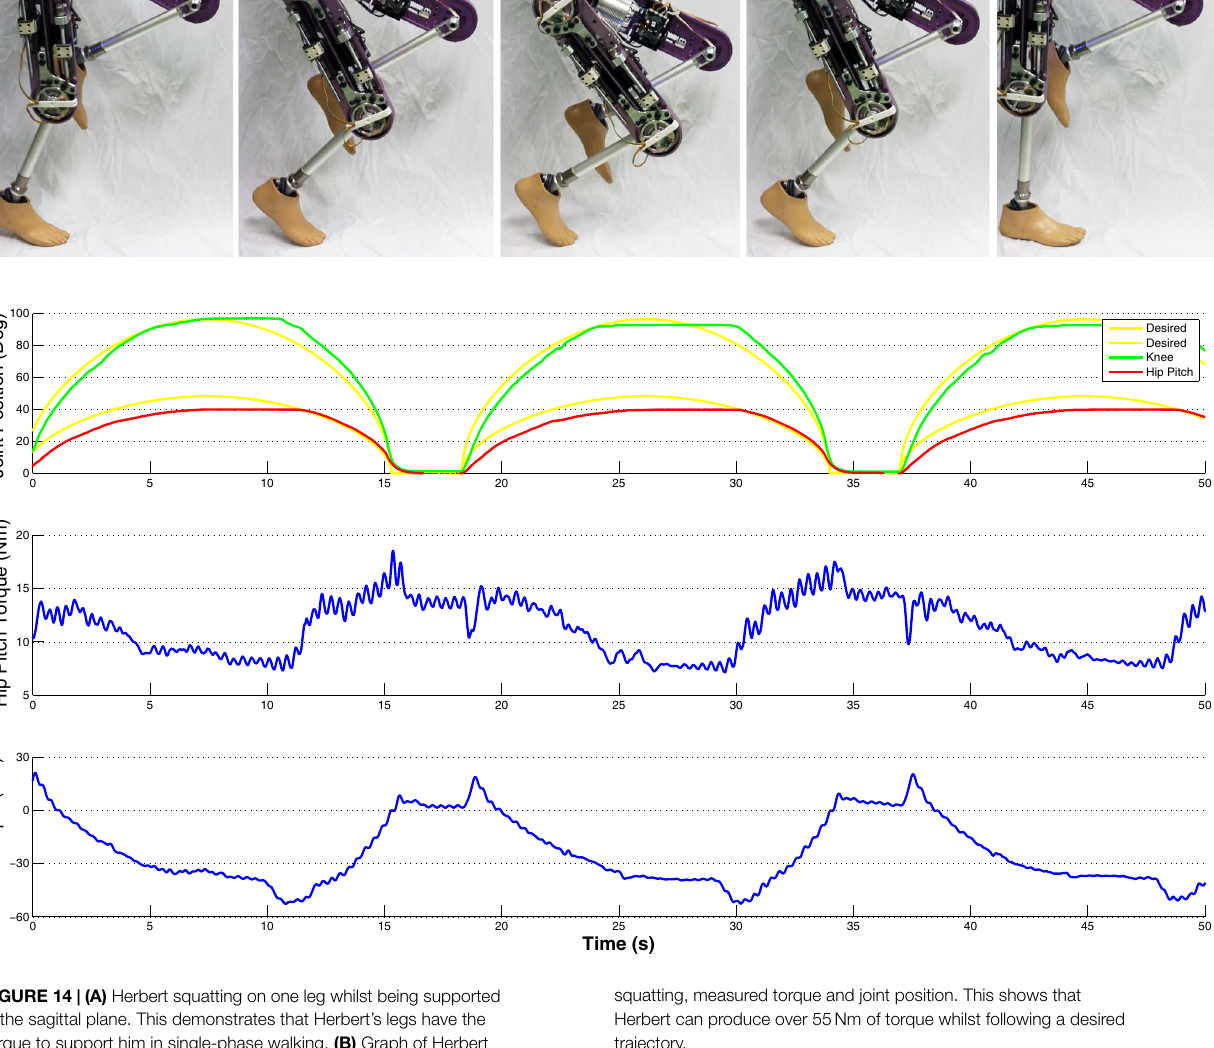
squatting, measured torque and joint position. This shows that Herbert can produce over 55Nm of torque whilst following a desired